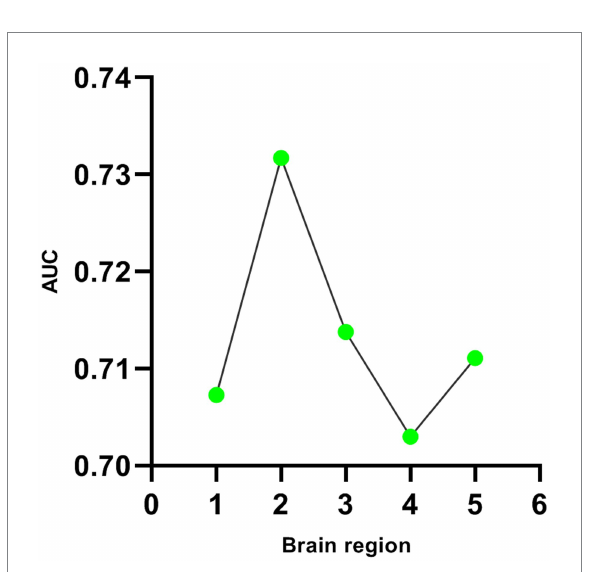
FIGURE 3 Line diagram of AUC in brain regions with abnormal DC values. The first green dot represents the bilateral cerebellum; The second green dot represents the left middle temporal gyrus; The third green dot represents the left fusiform gyrus; The fourth green dot represents the right medial orbital frontal gyrus; The fifth green dot represents the bilateral posterior cingulate